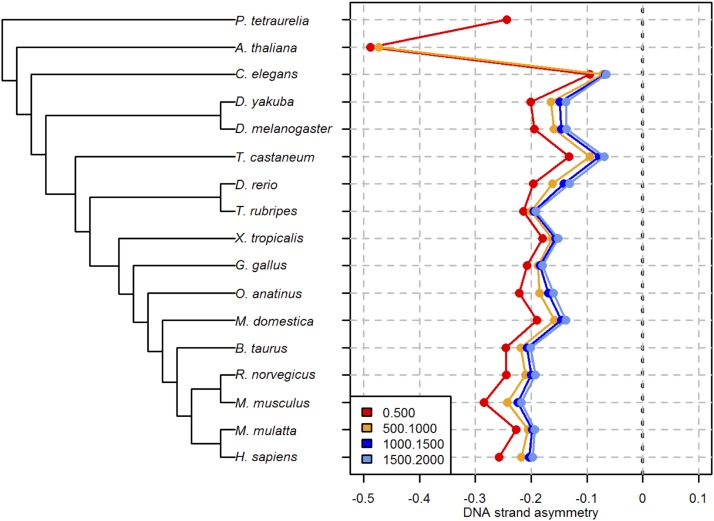
DNA strand asymmetry of the polyadenylation AATAAA motif (DSAAATAAA) in 500-nt intronic segments at increasing distances from the upstream 5′ss. Left panel: approximate phylogenetic relationships spanning ∼2 billion yr between the single-celled ciliate P. tetraurelia and H. sapiens. Right panel: DNA strand asymmetry of the AATAAA motif in four nonoverlapping intronic intervals. Only one interval (0–500 nt) was examined for P. tetraurelia, which has extremely short introns (25 bp on average; Aury et al. 2006). DSAAATAAA was computed for samples that consist of ≥500 sequences.